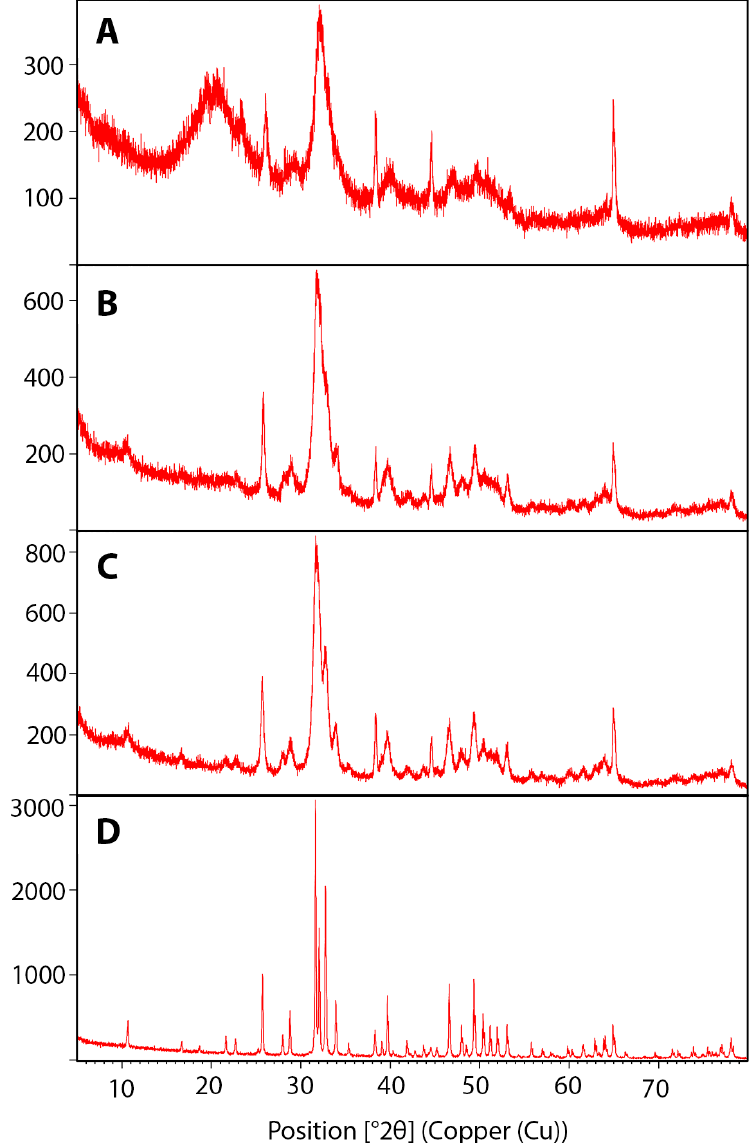
Figure 3. X-ray diffraction spectra of the different groups of bovine bone blocks. ( A ) Raw bone, ( B ) boil (6 h), ( C ) initial boiling (6 h) followed by 550 °C sintering (6 h), ( D ) initial boiling (6 h) followed by 1100 °C sintering (6 h). Table 2. Percentage crystallinity of bone samples after different processing methods.